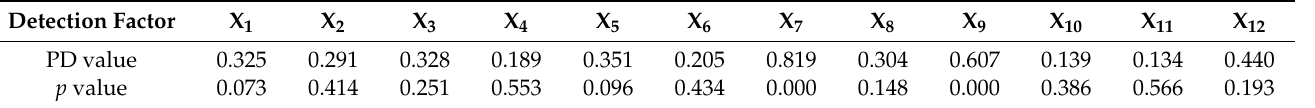
Table 3. PD values of detection factors.